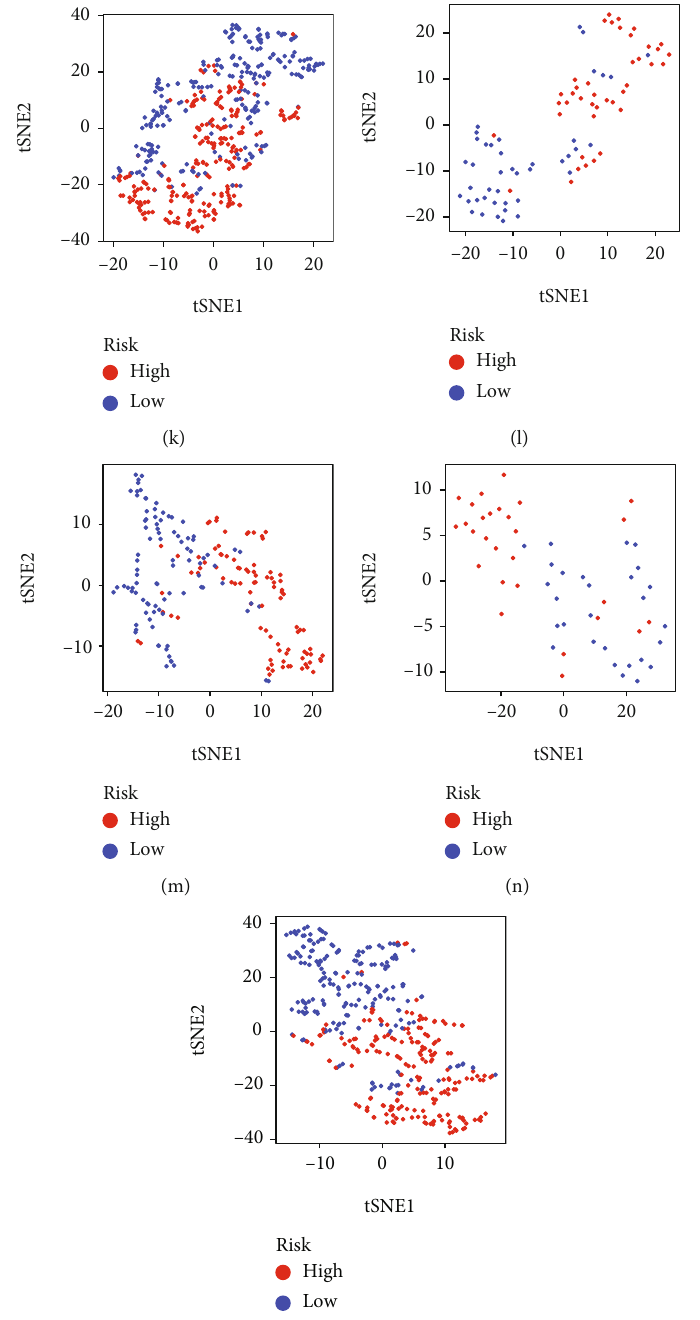
Figure 3: ROC, PCA, and tSNE analyses of training and testing sets. (a – e) ROC; (f – j) PCA analysis; (k – o) tSNE analysis. (a, f, and k) TCGA- LUAD. (b, g, and l) GSE30219. (c, h, and m) GSE41271. (d, i, and n) GSE50081. (e, l, and o)